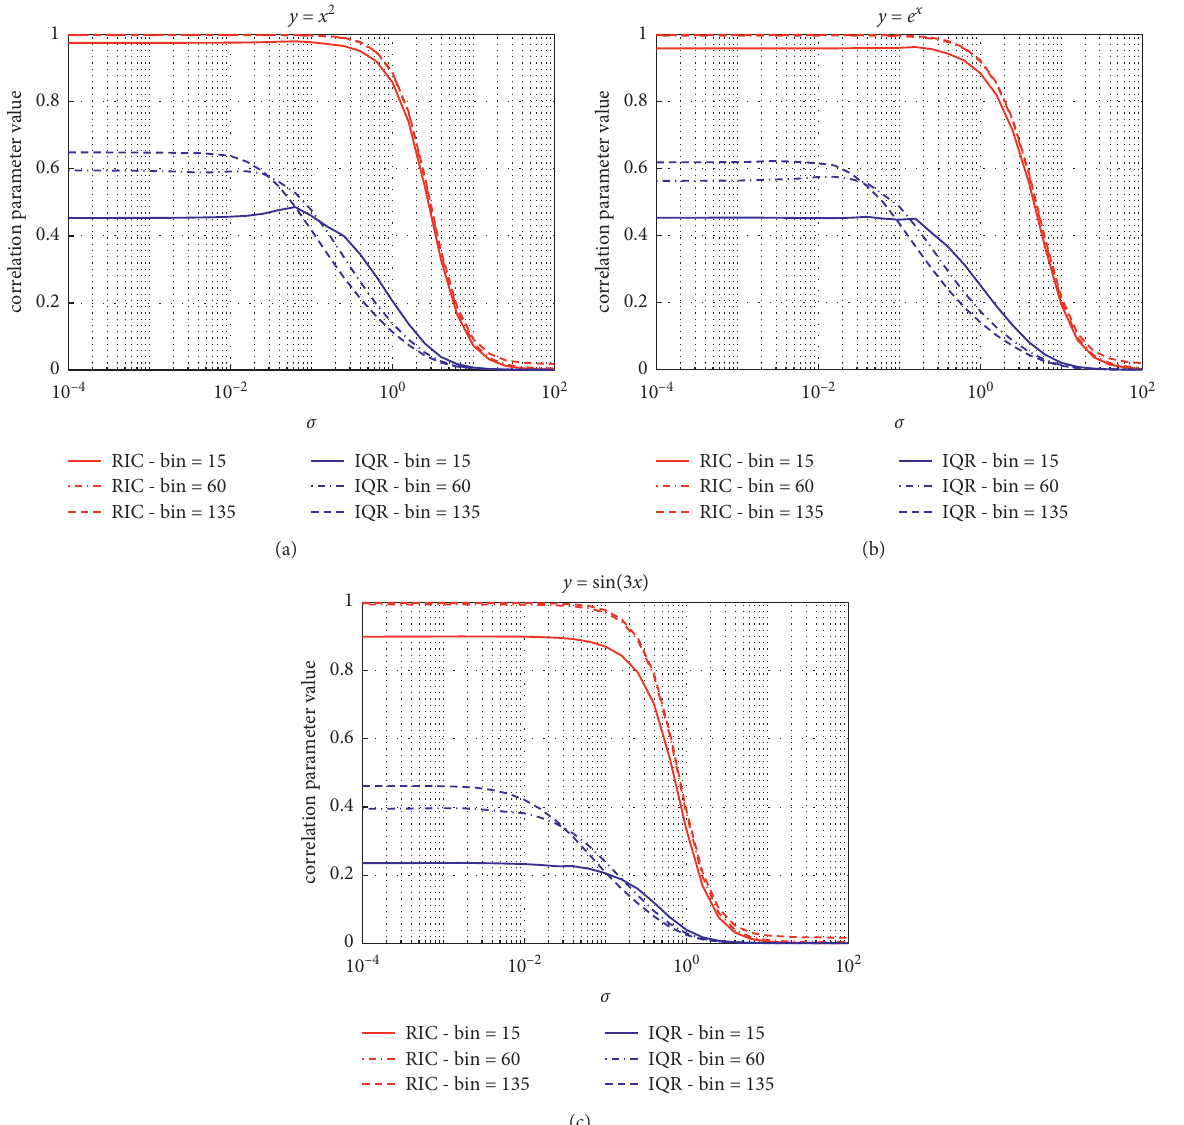
Figure 3: Behavior of PCC, IQR, and RIC with the standard deviation of the additive noise for various nonlinear dependencies. (a) y � x 2. (b) y � sin ( x ). (c) y � exp ( x